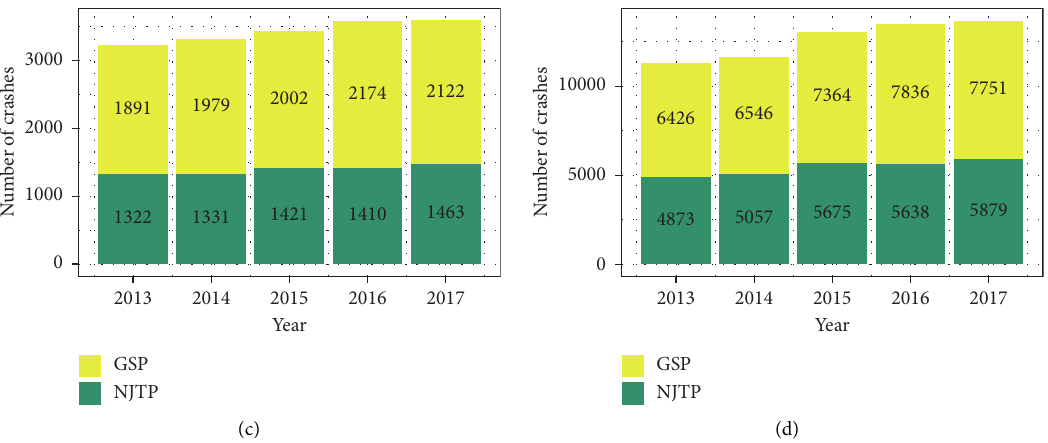
Figure 2: Number of crashes by years. (a) Total crashes, (b) fatal crashes, (c) injury crashes, and (d) PDO crashes.